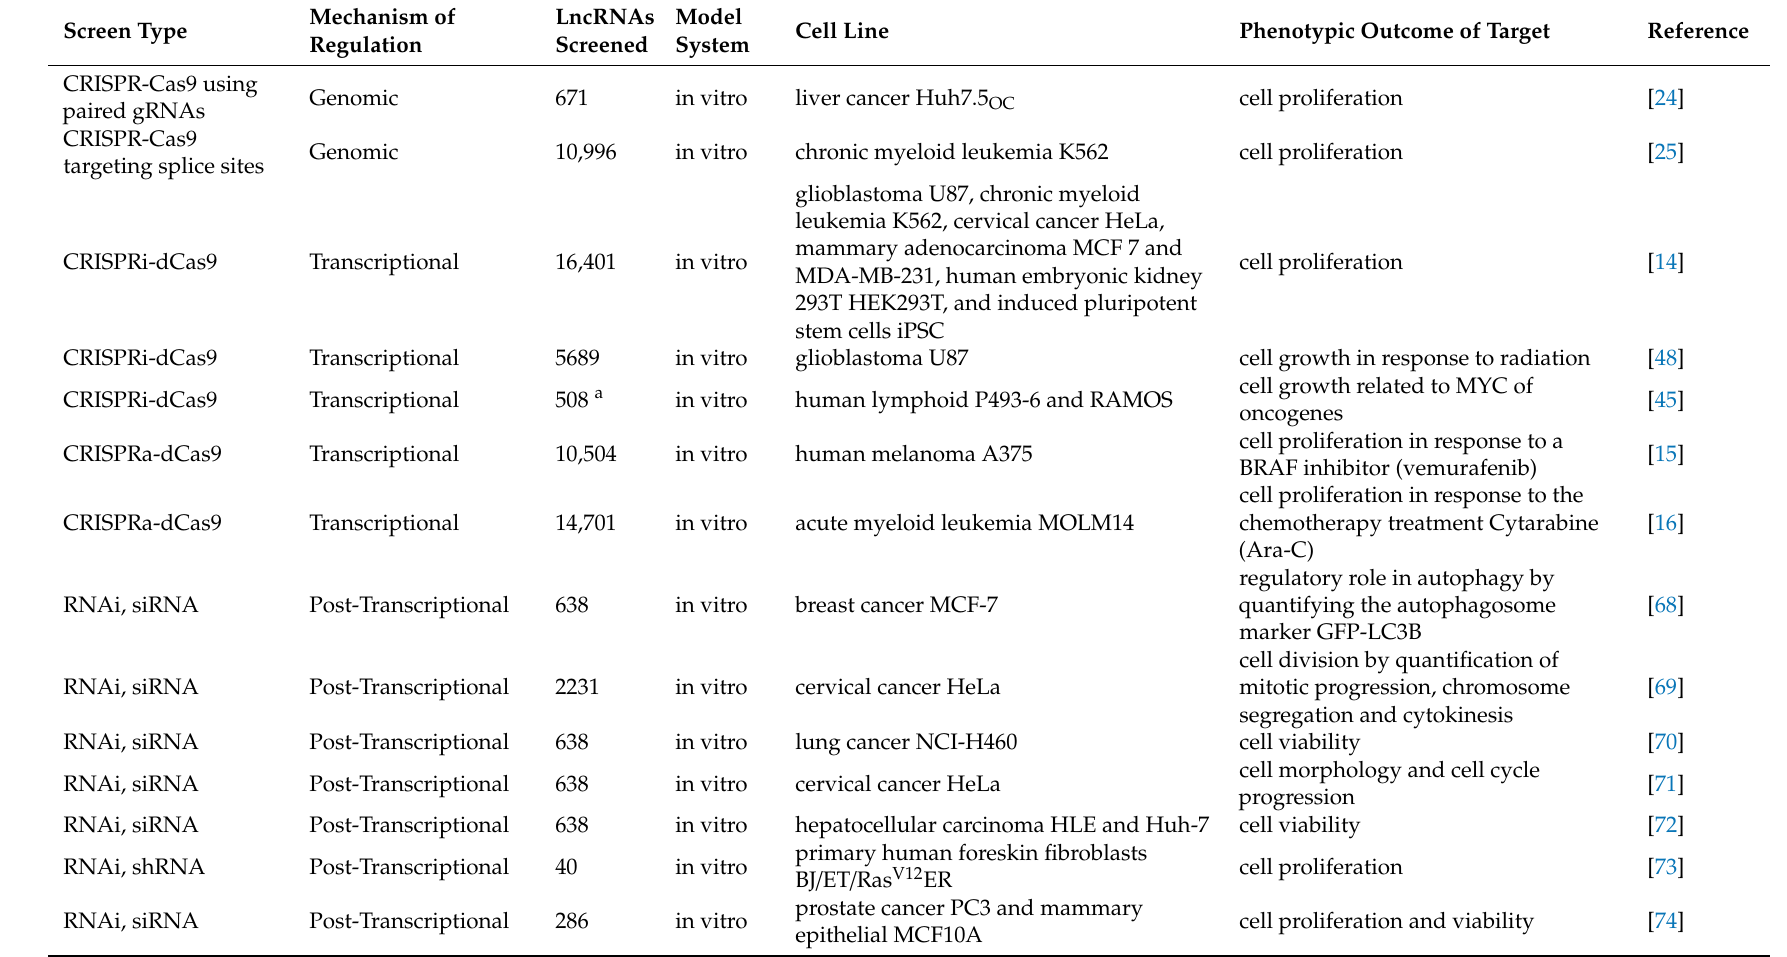
Table A1. Functional Oncogenic LncRNA